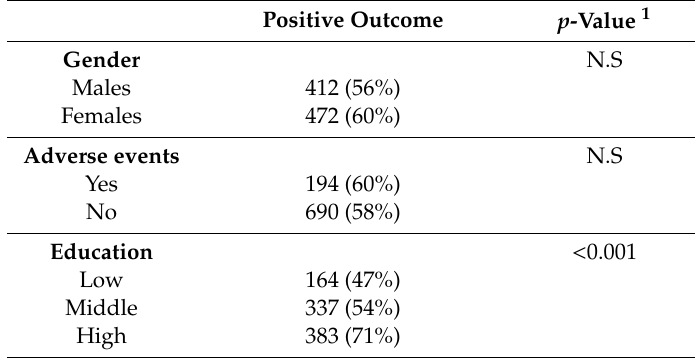
Table 3. Association between positive outcome and background